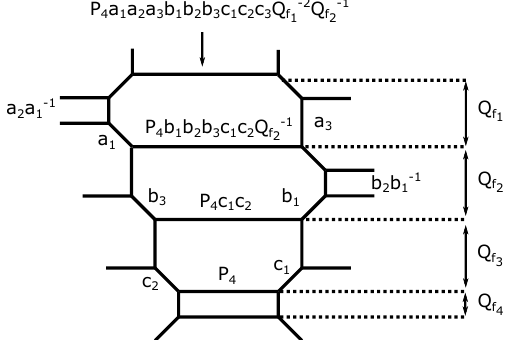
Figure 43. (a). Local geometry near the SU(5) part of the two rank 6 theories in (3.98). i labels the two rank 6 theories and i = 1 , 2 . (b). Local geometry near the SU(5) part of the rank 2 theory in (3.98).